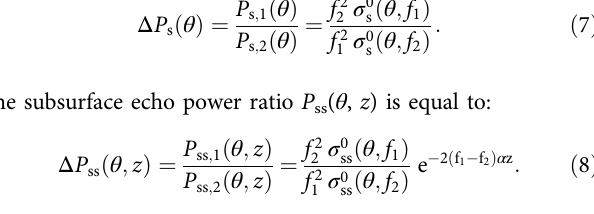
NATURE COMMUNICATIONS | 8: 2248 | DOI: 10.1038/s41467-017-02334-1 |